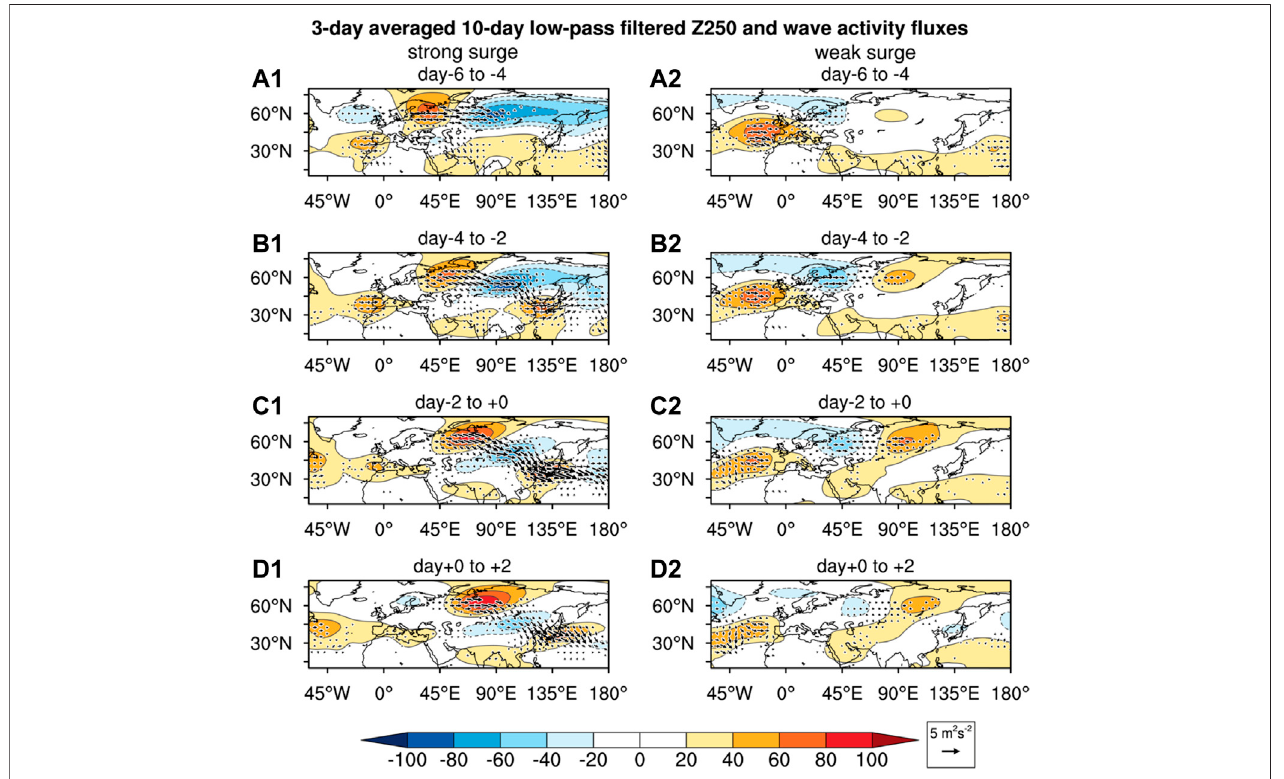
FIGURE7| The3-dayaveraged10-daylow-pass fi ltered250-hPageopotentialheightanomalies(shaded;m)andthestationarywaveactivity fl uxes(vector;m 2 s − 2 ) during the evolution of a (A1 – D1) strong and (A2 – D2) weak cold surge. Note that the zero contour lines are omitted and positive/negative values are denoted by solid/ dashed